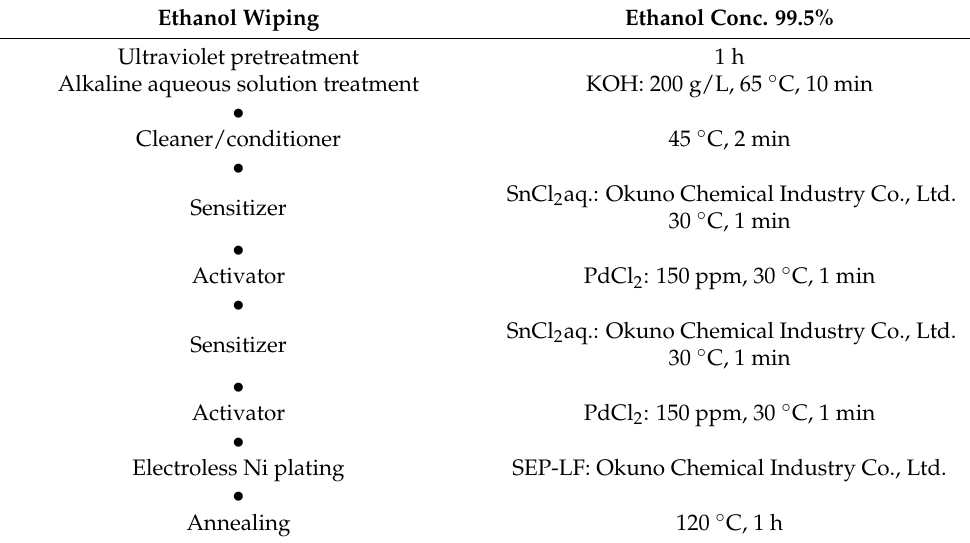
Table 2. Plating